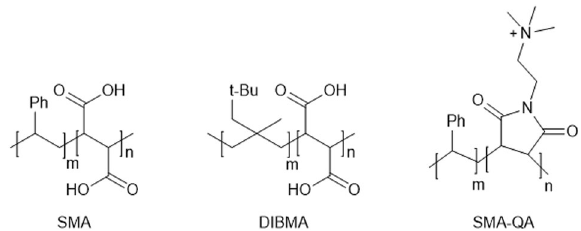
Fig. 1 Chemical formulas of the nanodisc-forming polymers used in this work. Unmodi fi ed SMA: m = 2.3 or 3, n = 1. DIBMA: m = 1, n = 1. SMA-QA: m = 3, n =